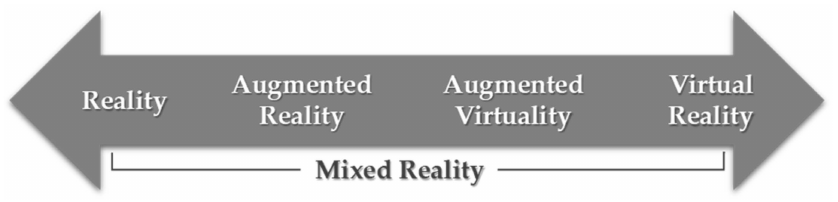
Figure 1. The virtuality